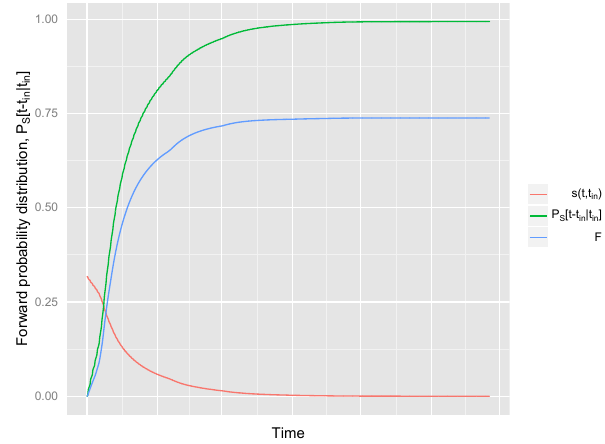
Figure 5. Forward residence time probability distribution: in red the relative storage, in green the forward residence time distribution and in blue the relative discharge function.